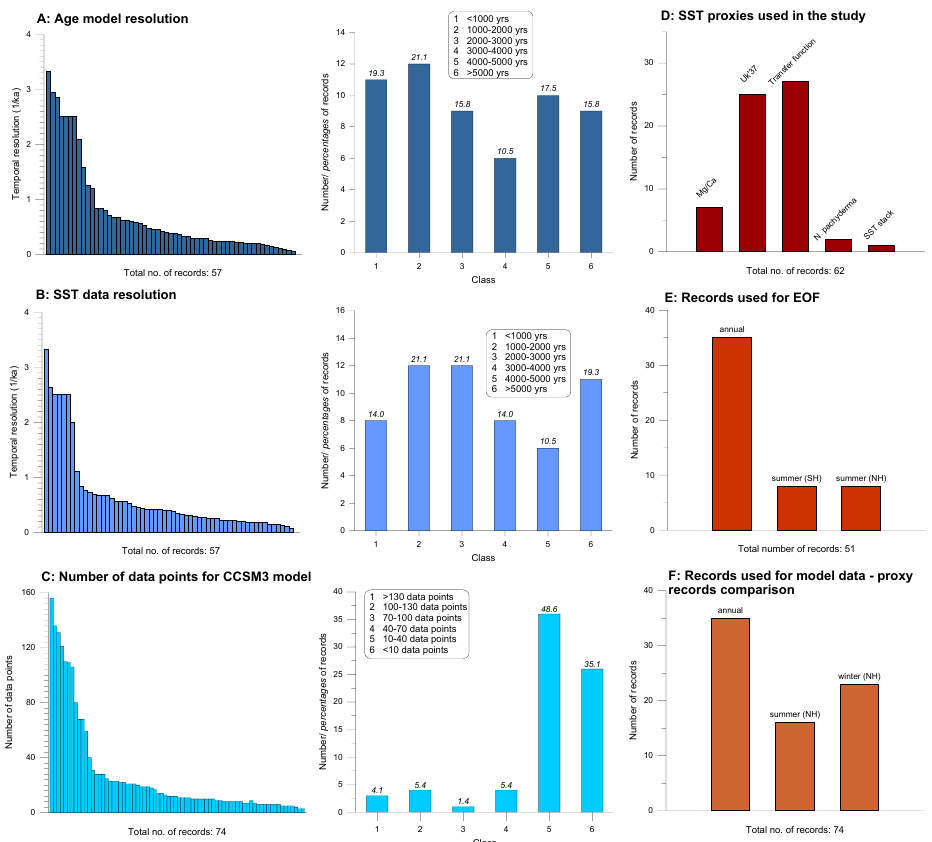
Fig. 3. Mean temporal resolution of the age models based on stable oxygen isotope records used in this study (A) . Mean temporal resolution of the SST records used in this study (B) . Number of available data points for the comparison of the proxy and model data temperature anomalies for the 390–420ka time interval and number (C) . Number of SST records used in this study for each proxy (D) . Seasonal attribution of SST records used for the empirical orthogonal function (EOF) analysis (E) and seasonal attribution of SST records used for the proxy–model data comparison (F)